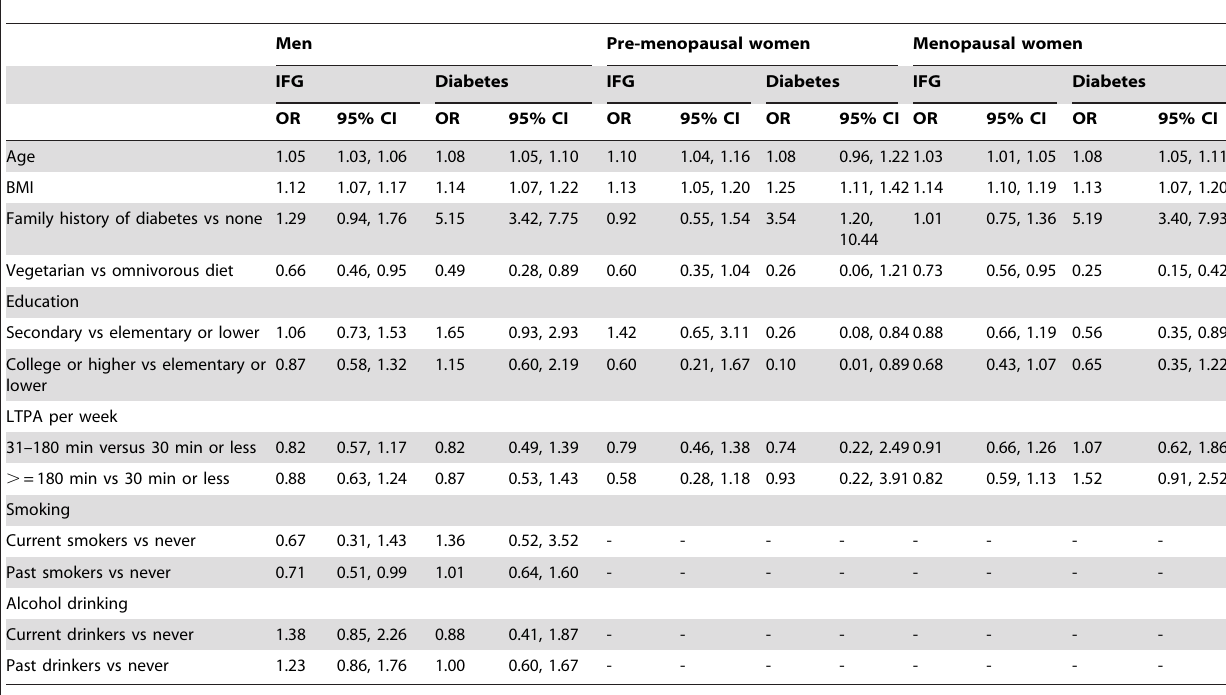
Table 4. Polytomous logistic regression analysis of the association between diet and impaired glucose